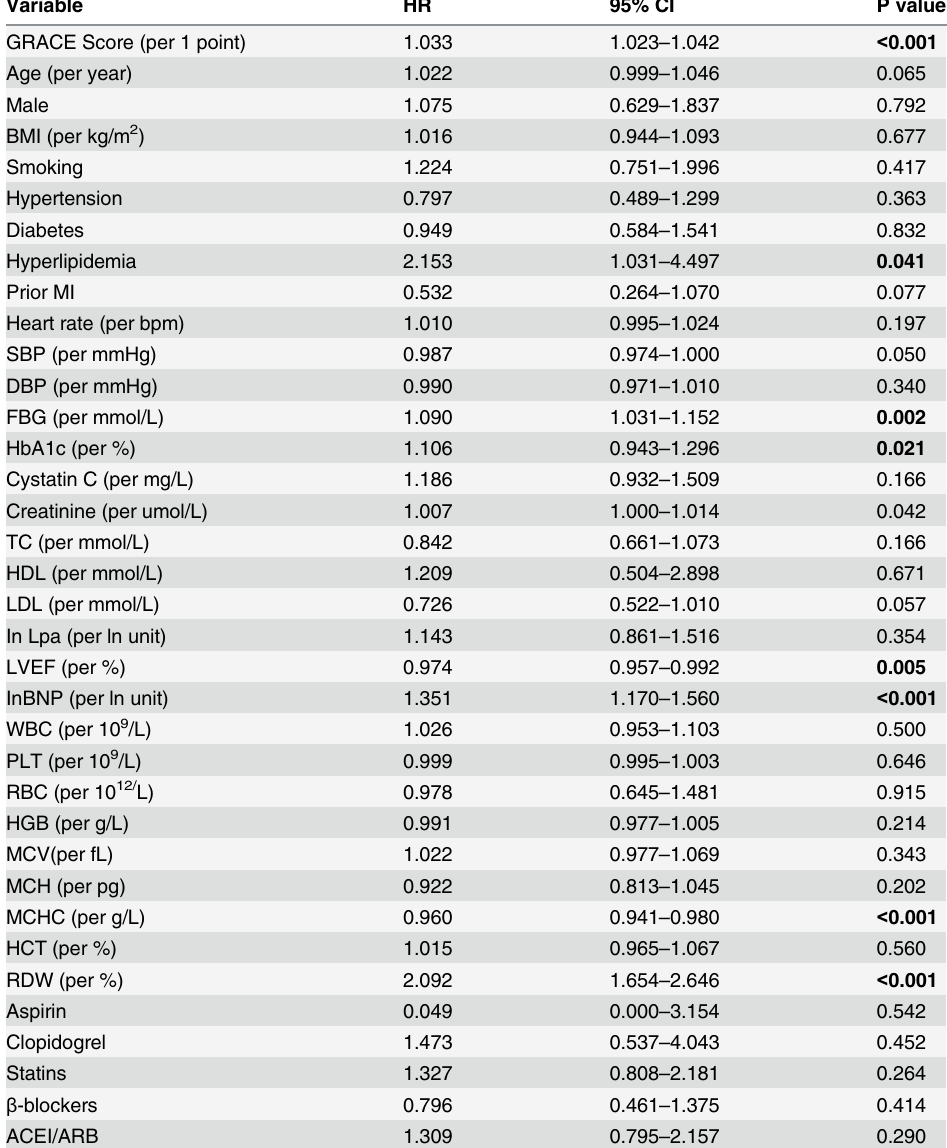
Table 3. Univariate Cox analysis for major adverse cardiovascular events.